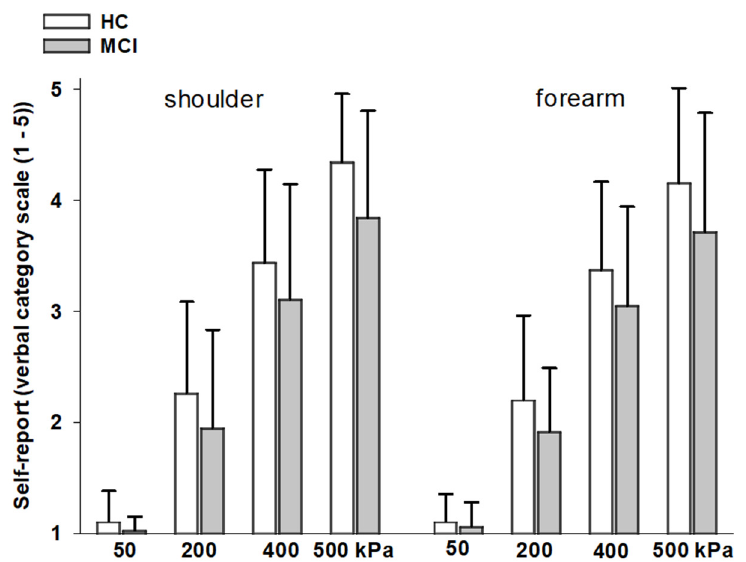
Figure 1. Pain responses (verbal ratings, mean and SD) across pressure intensities. Values are given separately for the two stimulation sites and separately for the two groups. In line with this, intercept and slope values (derived from the individual’s psycho- physical curve of pain ratings across pressure intensities) also did not differ between groups (F(4,58) = 0.744, p = 0.566; see also Table 1). Executive Functioning and Memory Performance Predicting Pain Responsiveness The results of the regression analyses can be found in Table 2 (slope) and Table 3 (intercept), respectively. Table 2. Hierarchical regression analysis for executive and memory functions predicting the slope of pain responsiveness (increase in pain ratings across all pressure intensities). Findings are given separately for the two stimulation sites and the two subject groups.